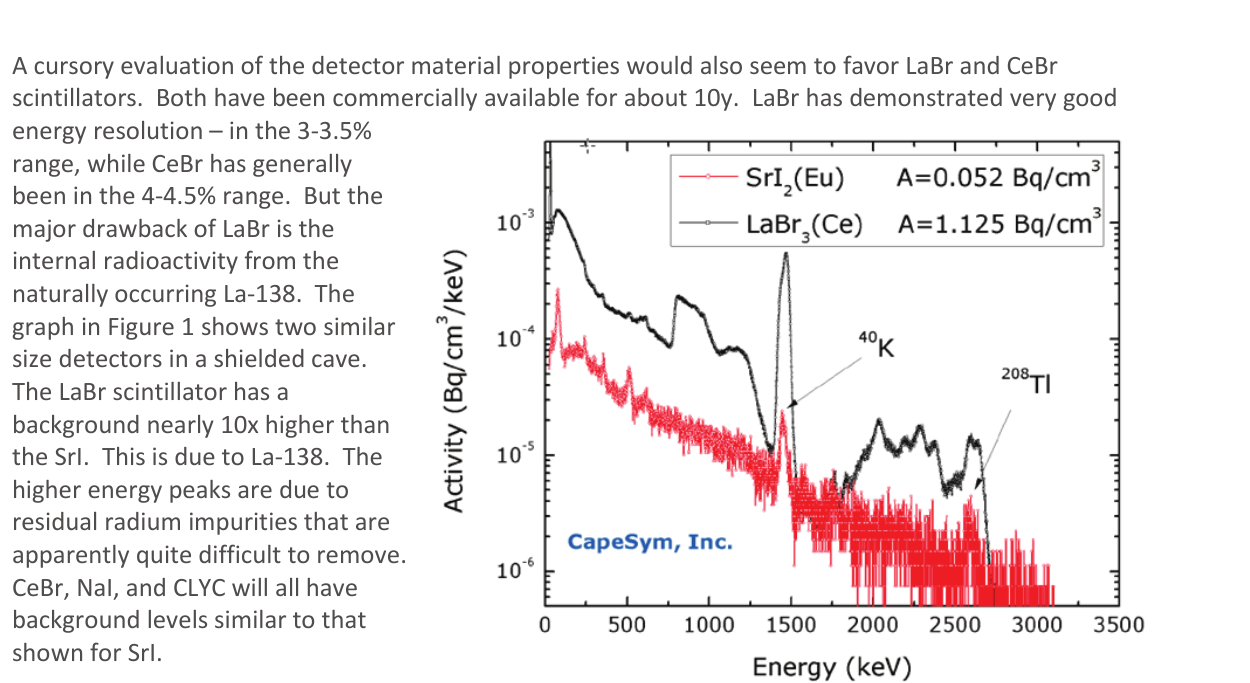
Figure 1 Shielded background for SrI and LaBr detectors of similar